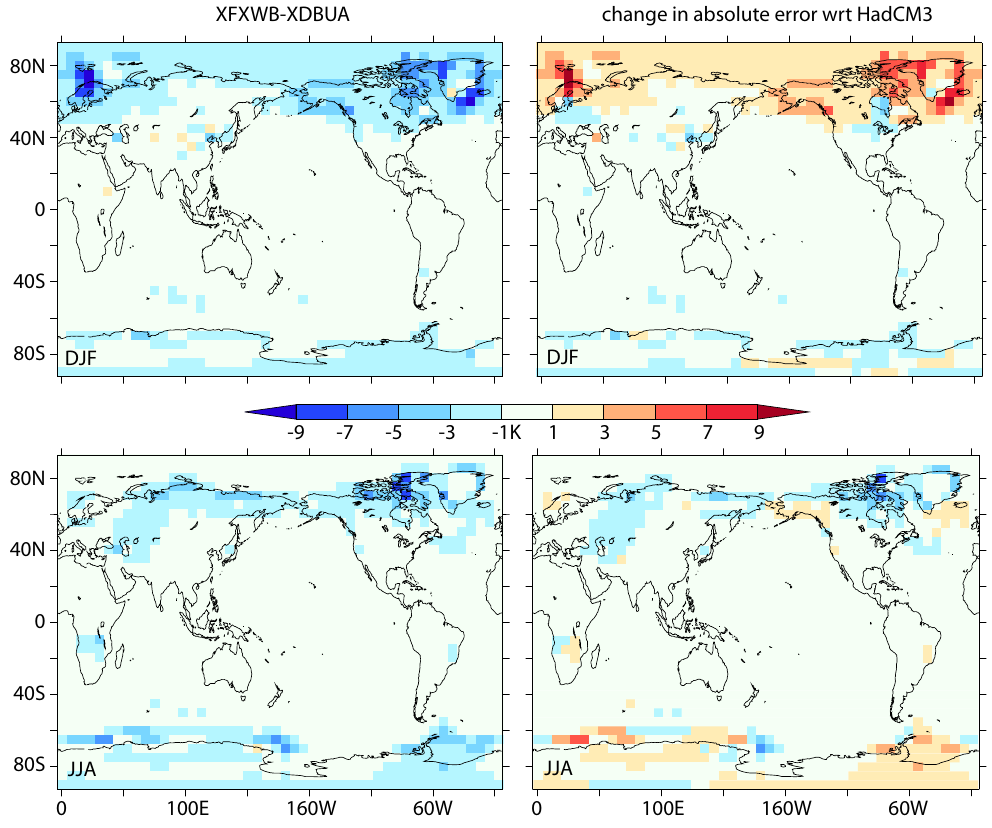
Fig. 1. Difference in seasonal surface temperature. Left: XFXWB-XDBUA; right: change in magnitude of error with respect to HadCM3; top: DJF; below: